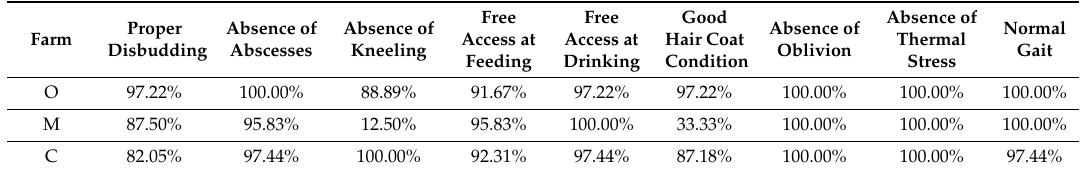
Table 2. Result of the application of the AWIN (Animal Welfare Indicators) protocol, expressed as proportion of animals with no welfare problems for each specific